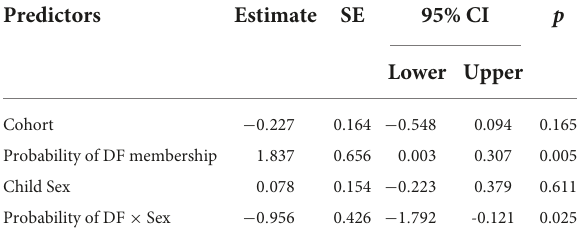
TABLE 5 Summary of multiple regression of membership in dysregulated fear (DF) profile, child sex, and their interactions on child self-report of overanxiousness on the BPI.